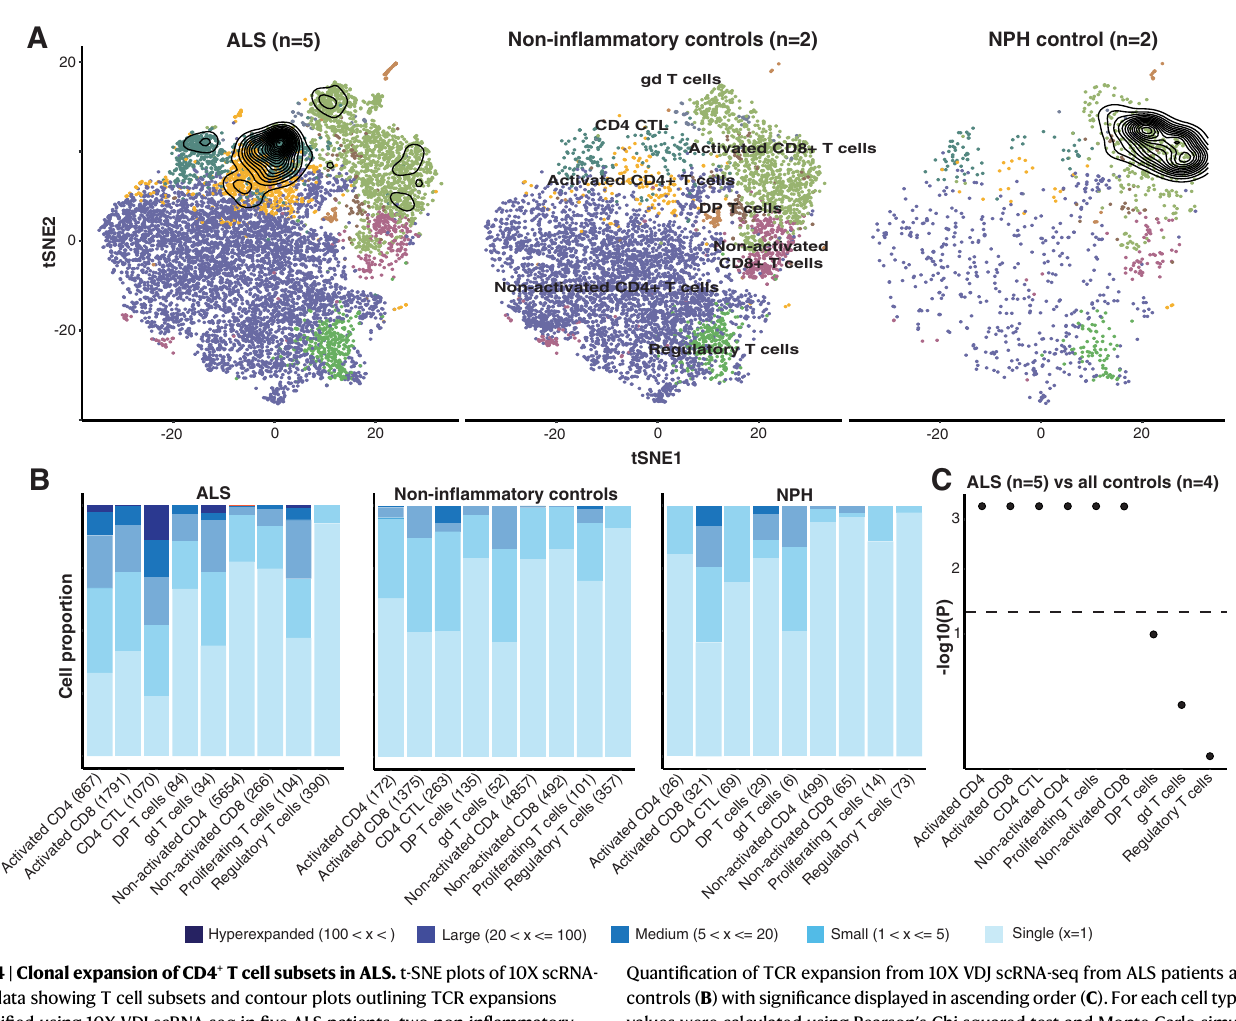
Fig.4|ClonalexpansionofCD4 + TcellsubsetsinALS. t-SNEplotsof10XscRNA- seq data showing T cell subsets and contour plots outlining TCR expansions identi fi ed using 10X VDJ scRNA-seq in fi ve ALS patients, two non-in fl ammatory controls, and two normal pressure hydrocephalus (NPH) controls individuals ( A ).